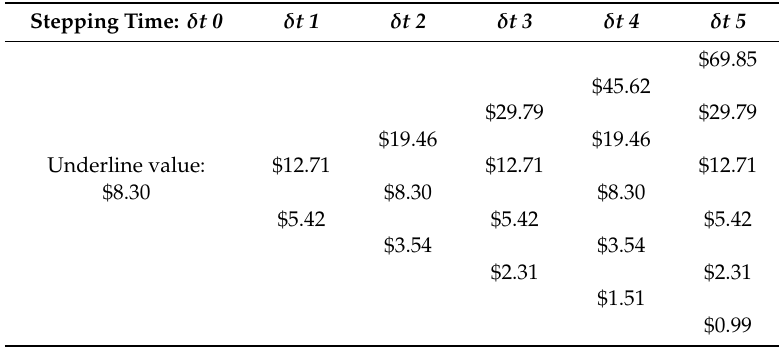
Table 11. Binominal option pricing model. The lattice of the underline values of Natura’s acquisition of Avon Products Inc. (in US$ bn).